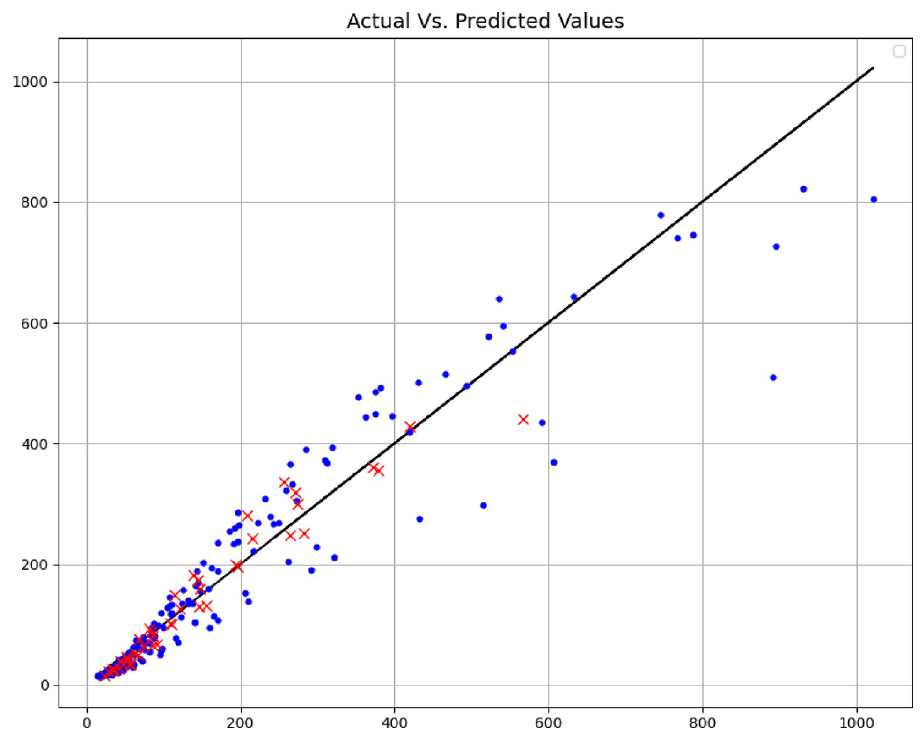
Fig 6. Actual Vs. estimated outputs (MLP